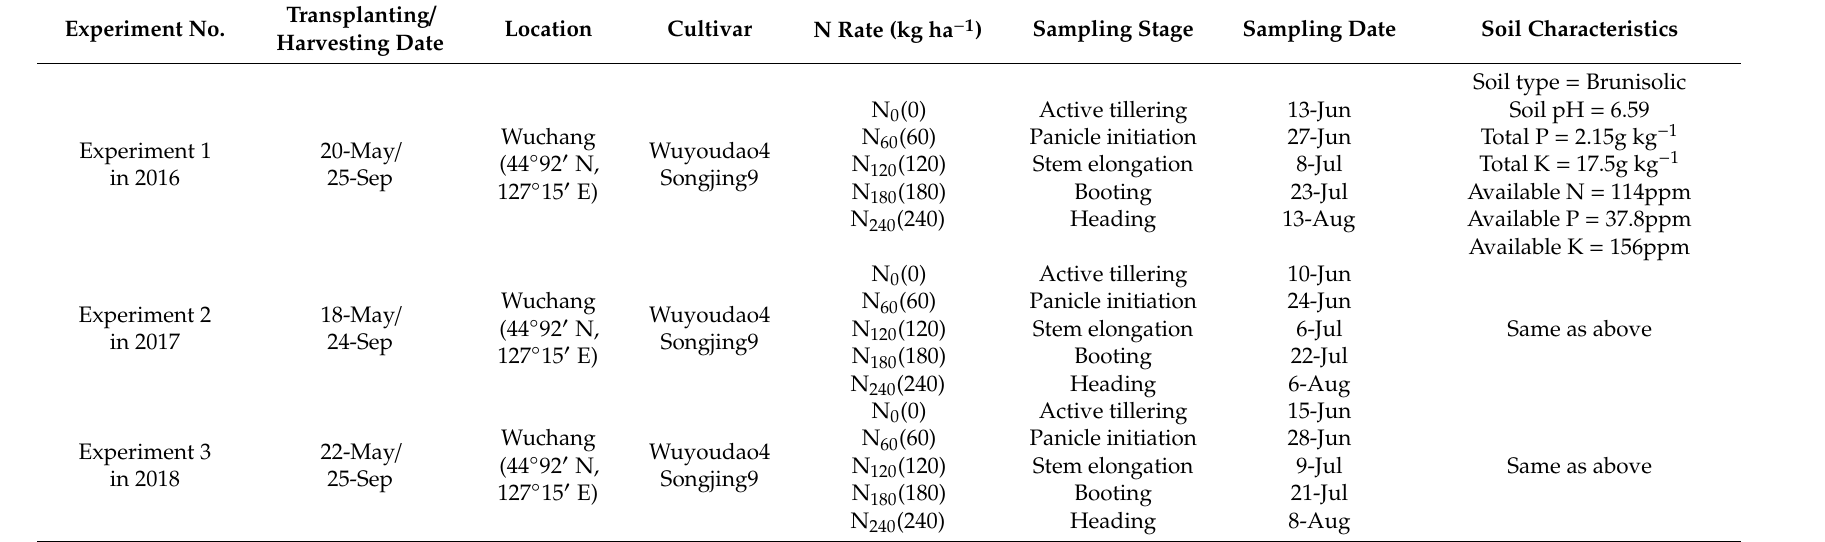
Table 1. Basic information about three